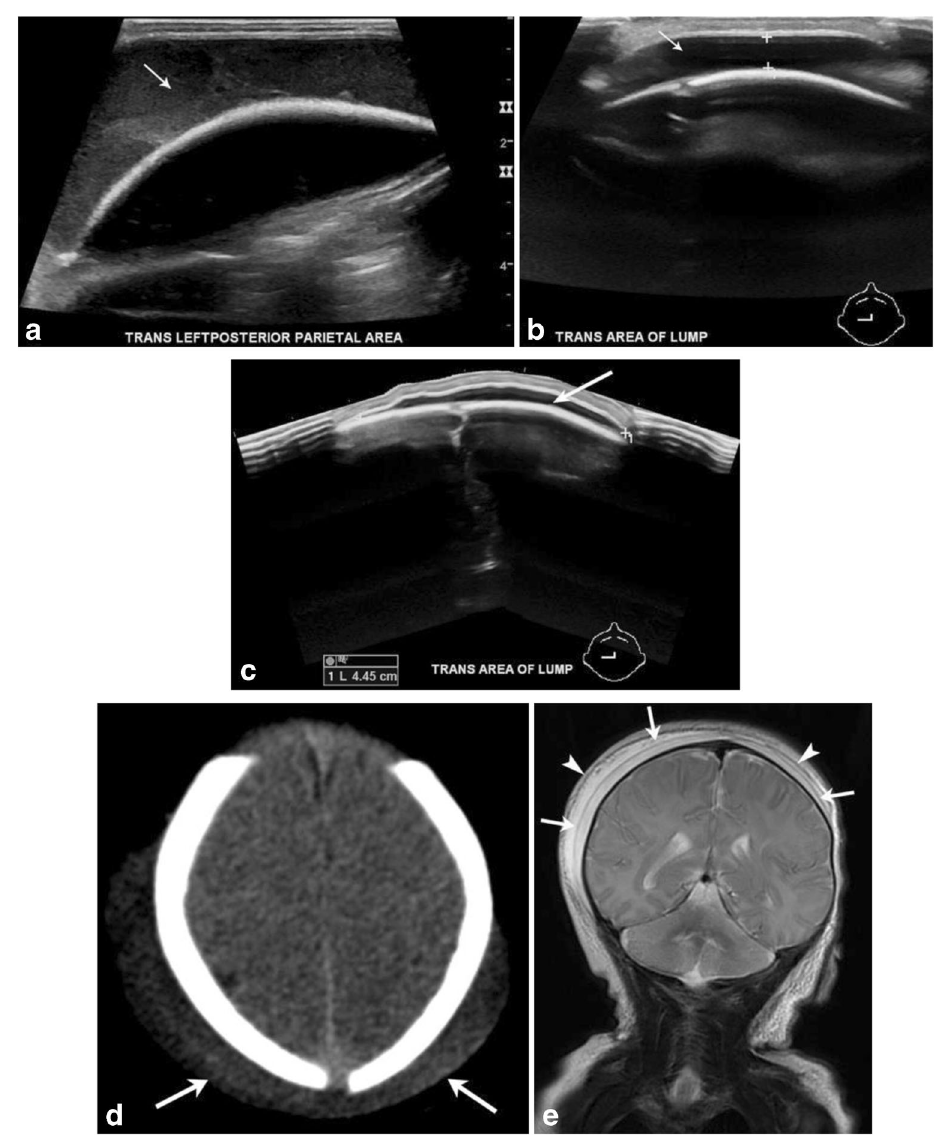
Fig. 3 Caput succedaneum and subgaleal hemorrhage Grayscale ultrasound images (a-c) of the scalp in a newborn male demonstrate a fluid collection that crosses midline, is deep to the subcutaneous fat/galeal aponeurosis and superficial to the periosteum/calvarium (noted as thick echogenic interface) consistent with a subgaleal hemorrhage. Axial CT (d) image in a 1-day-old male with history of traumatic delivery demonstrate scalp soft tissue overlying bilateral parietal regions and crossing the sagittal suture (arrows). Follow-up coronal MR image (e) demonstrates a deep subaponeurotic scalp fluid collection crossing the sagittal suture and extending anteriorly into the right temporal region, consistent with subgaleal hematoma (arrows). A more superficial overlying fluid collection with a similar distribution also noted (arrowheads). This collection is withinthe subcutaneousfibrofatty tissues superficial to galea aponeurosis and is consistent with caput